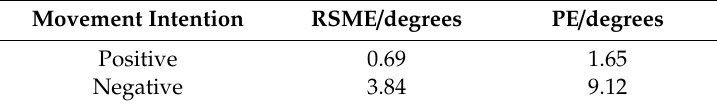
Table 6. Experimental results under the condition of variable